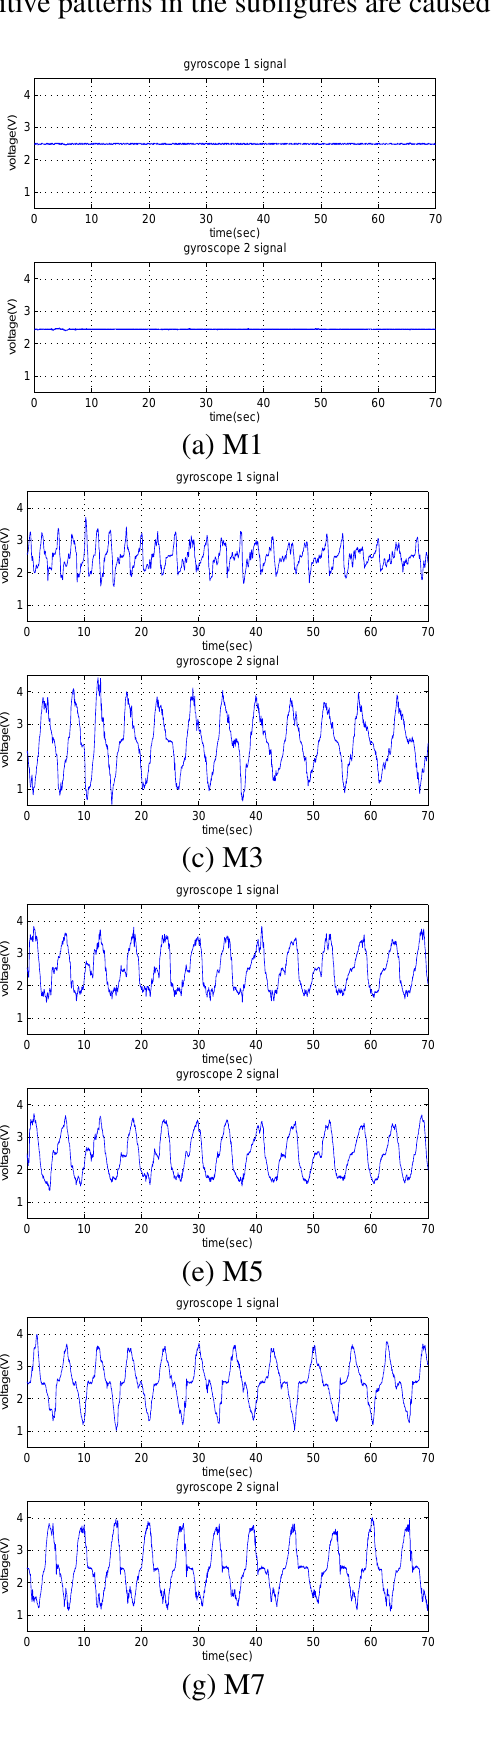
Figure 5. Sample signal recordings of the two gyroscopes for each type of motion. The repetitive patterns in the subfigures are caused by repeating the motion 10–14